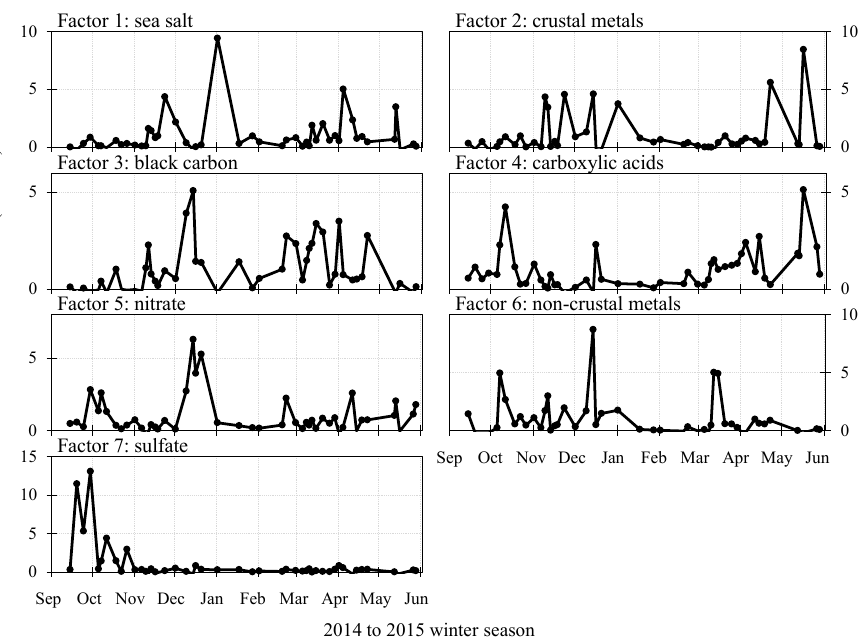
Figure 2. Normalized factor contributions. The unitless contributions describe the relative magnitude of each factor over time such that the average contribution of each factor is one. For example, for the snowfall in early January Factor 1 sea salt had a contribution that was approximately 10 times its average contribution over the